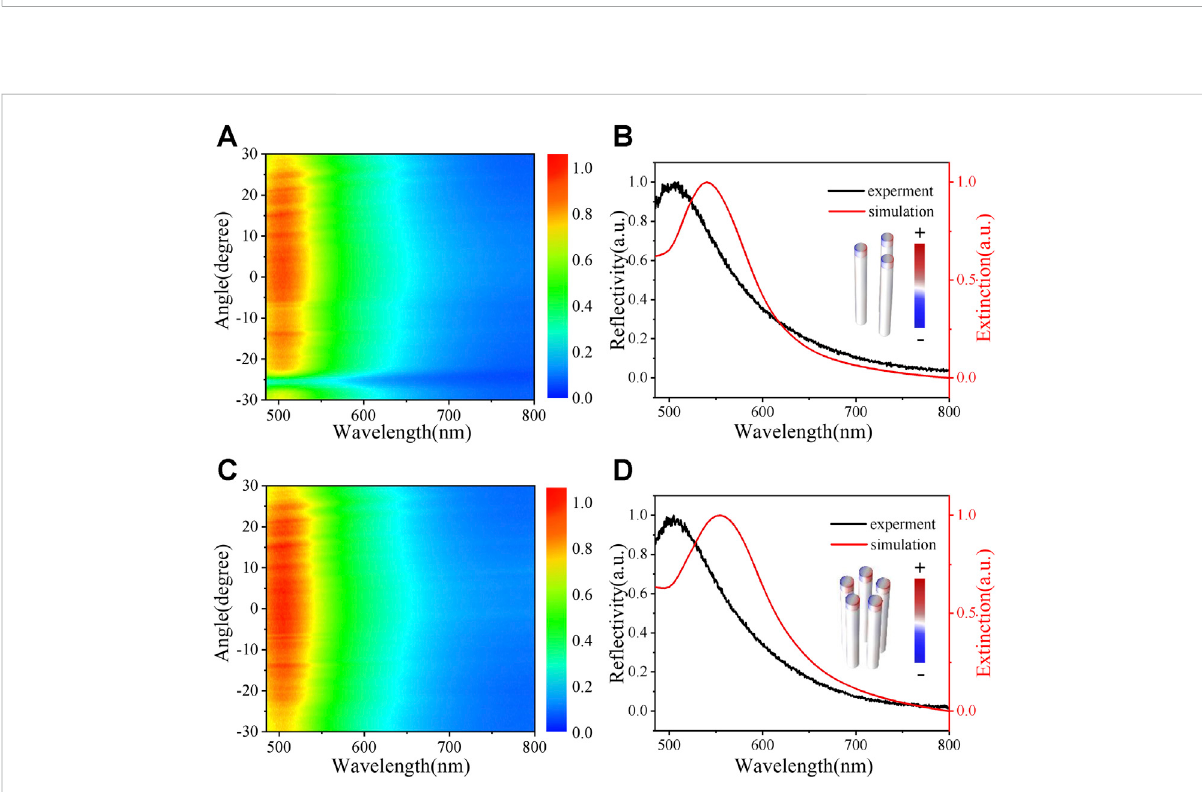
FIGURE 2 Experimentallymeasuredandnumericallysimulatedre fl ectionspectraoftrimerorpentamerAunano fi ngerarrayswithlatticeconstantof5 μ m. (A) Experimentally measured angle-resolved re fl ection spectra of trimer Au nano fi nger arrays. (B) Experimentally measured re fl ection spectra and numerically simulated extinction spectra of trimer Au nano fi nger arrays with normal incidence. Inset: corresponding charge distribution with resonant excitation. (C and D) Corresponding data for pentamer Au nano fi nger